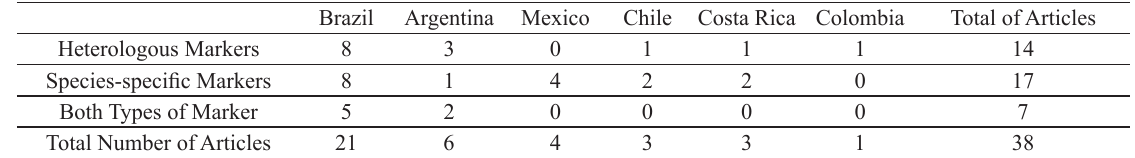
Number of scientific articles published between January 1990 and July 2015 by authors from six countries of the Neotropical Region that used heterologous, species-specific or both types of microsatellites markers for studies of wild birds, concerning population genetic studies or